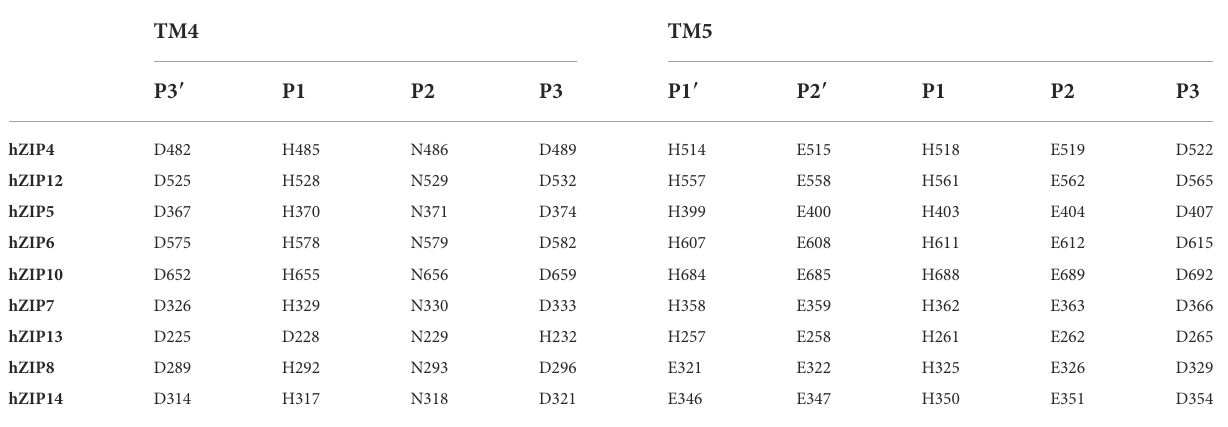
TABLE 4 Subgroup LIV-1 TM4 and TM5 BMC